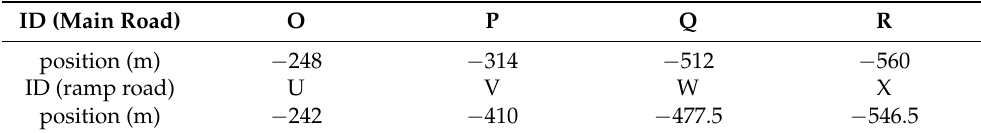
Table 3. The parameters of the vehicles for case study 2.